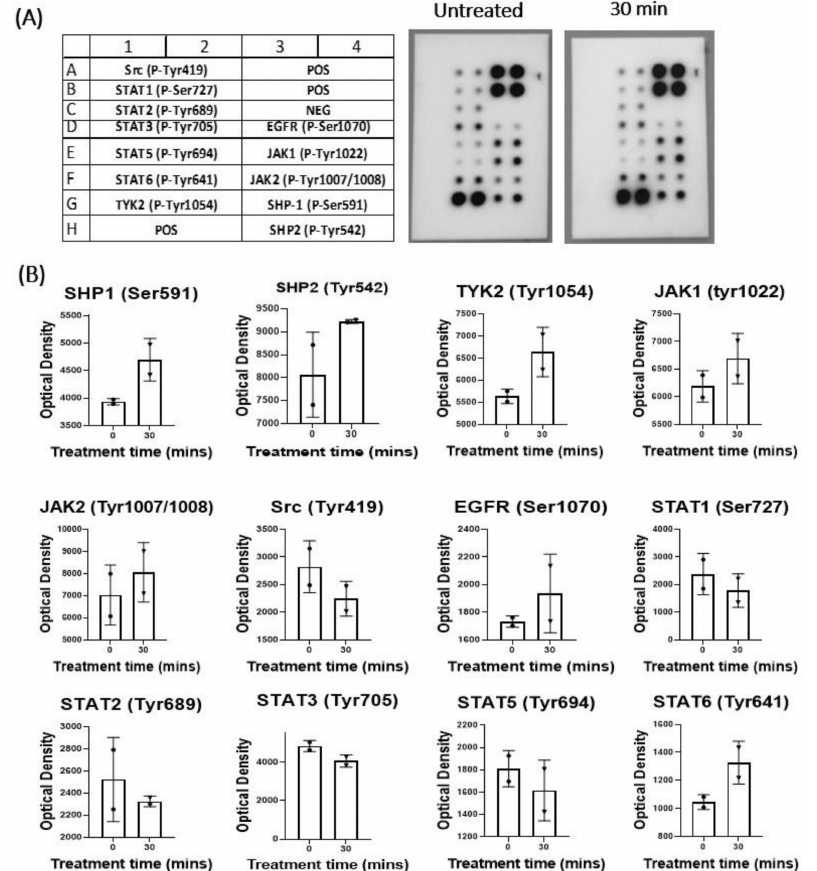
Figure A2. Array of JAK/STAT phosphorylation in ARPE19 cells in response to IL-17A treatment. Human ARPE-19 cells were treated with 50 ng/mL IL-17A for 30 min. Protein extracted from n = 4 independent experiments were pooled for array analyses, with one membrane per time point. ( A ) Array blot images from control and IL-17A treated group and blot identities were shown in the table. ( B ) Graphs showing the expression levels of the phosphorylated form of JAK/STAT family